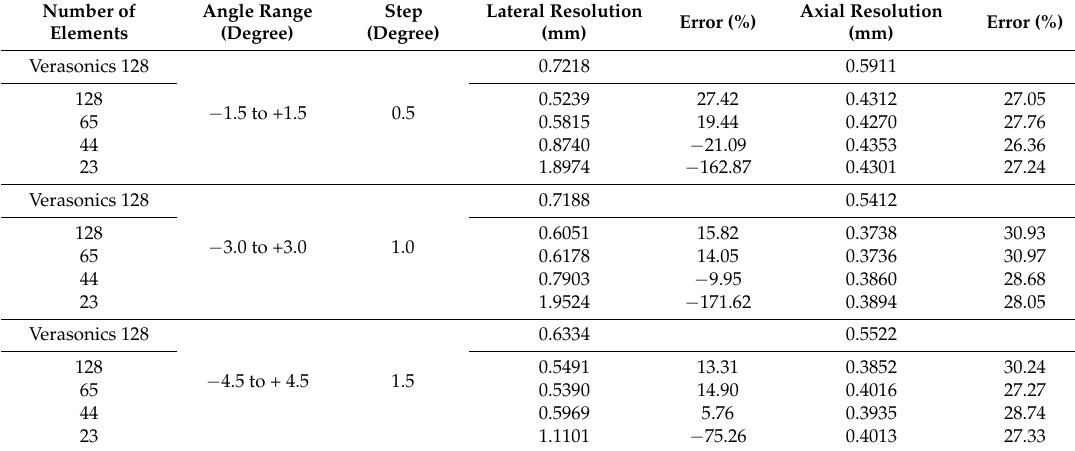
Table 6. FWHM—Lateral and axial resolution analysis and percentage error for the images of the target located at 1.7 cm in the phantom.